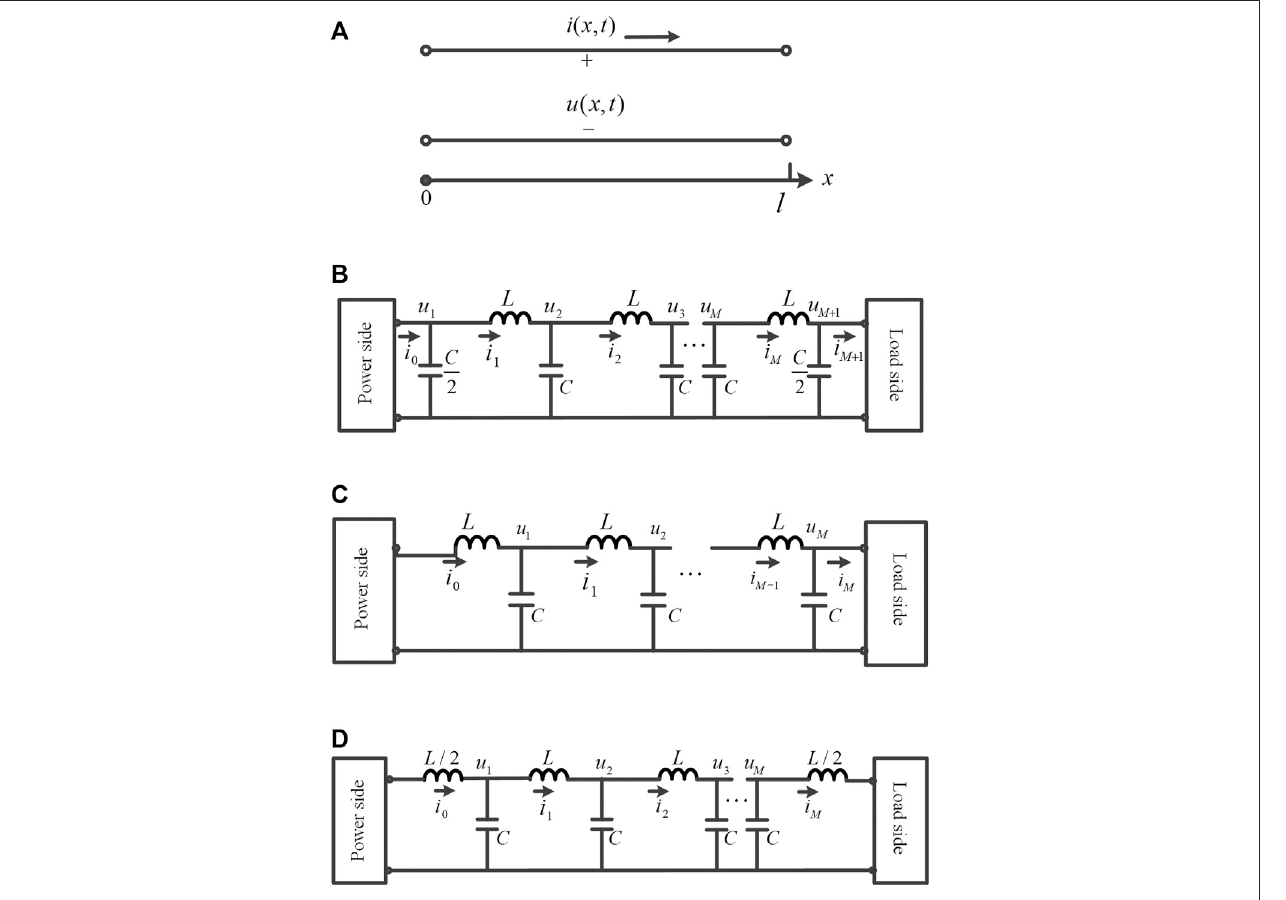
FIGURE 1 | Lossless transmission line and its three equivalent lumped-circuits. (A) Lossless transmission line. (B) Lumped-circuits consisted of M Π -type circuits. (C) Lumped-circuits consisted of M inverse Γ -type circuits. (D) Lumped-circuits consisted of M T -type circuits.